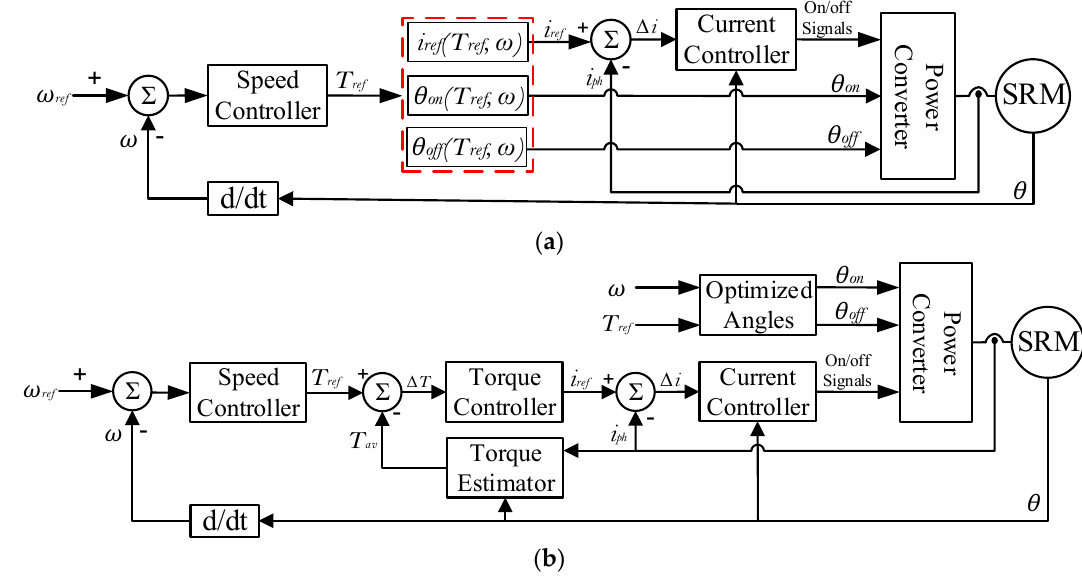
Figure 1. Block diagram of the average torque control (ATC) strategies: ( a ) indirect average torque control (IATC); ( b ) direct average torque control (DATC).